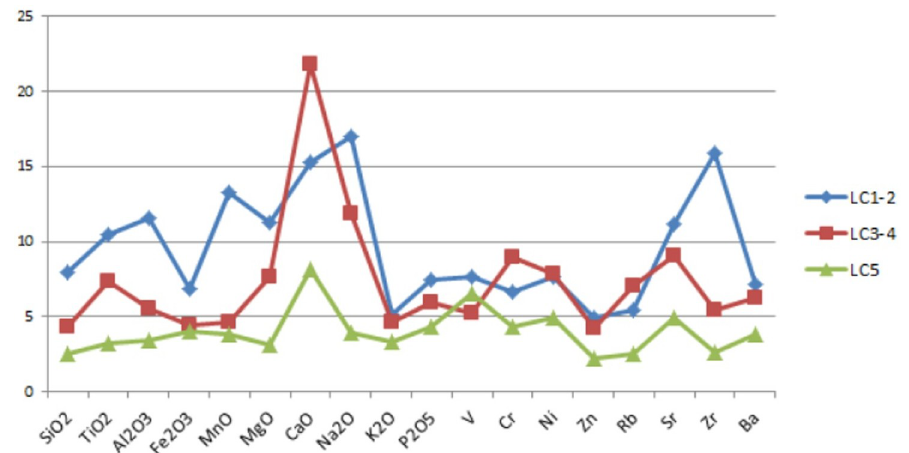
Fig 8. Elemental variance within each LC sub-phase. The variance of an element is equal to the trace of the variance- covariance matrix of the log-ratio transformed data using this element as divisor [91, 93].